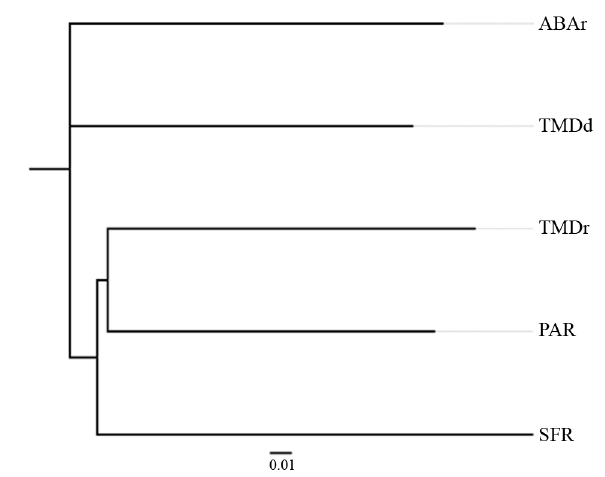
Fig. 3. Dendrogram representing the chord genetic distance among sampling groups of Prochilodus costatus . ABAr = rio Abaeté at rainy season; PAR = rio Paracatu lagoons; SFR = rio São Francisco lagoons; TMDd = Três Marias Dam at dry season; TMDr = Três Marias Dam at rainy